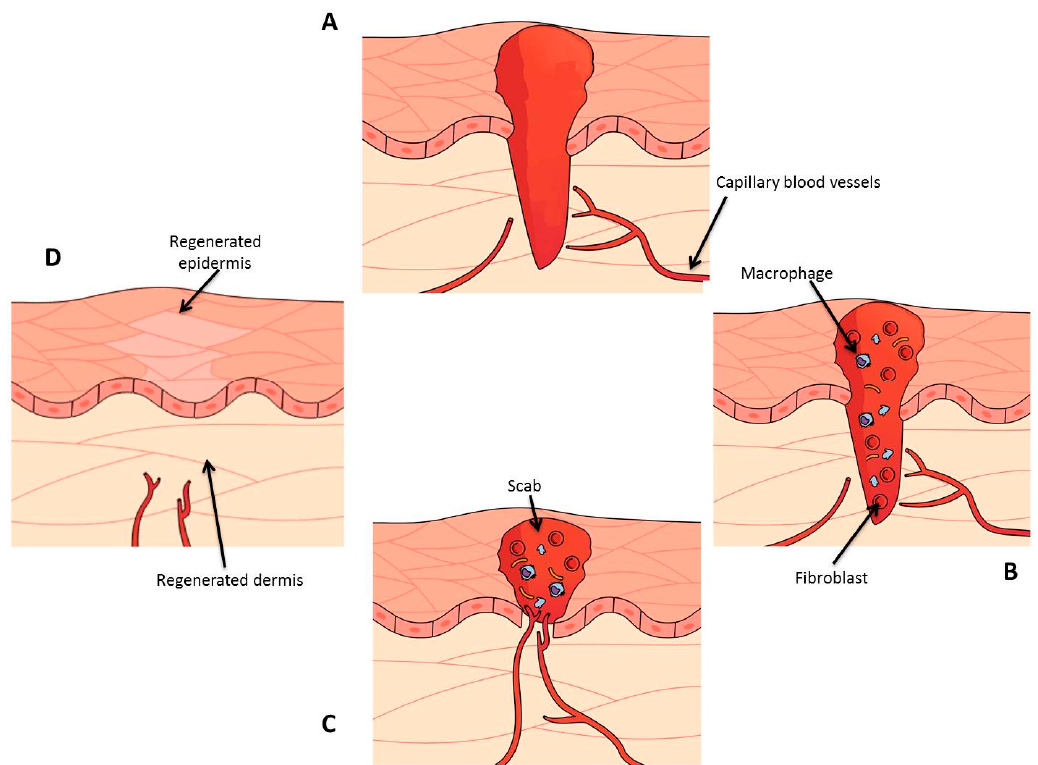
Figure 2. This figure depicts the four stages of wound healing, which are ( A ) hemostasis, ( B ) inflammation, ( C ) proliferation, and ( D ) extracellular matrix remodeling. During wound healing, fibroblasts (the body’s connective tissue cells) and macrophages, which defend against infection, play an enormous